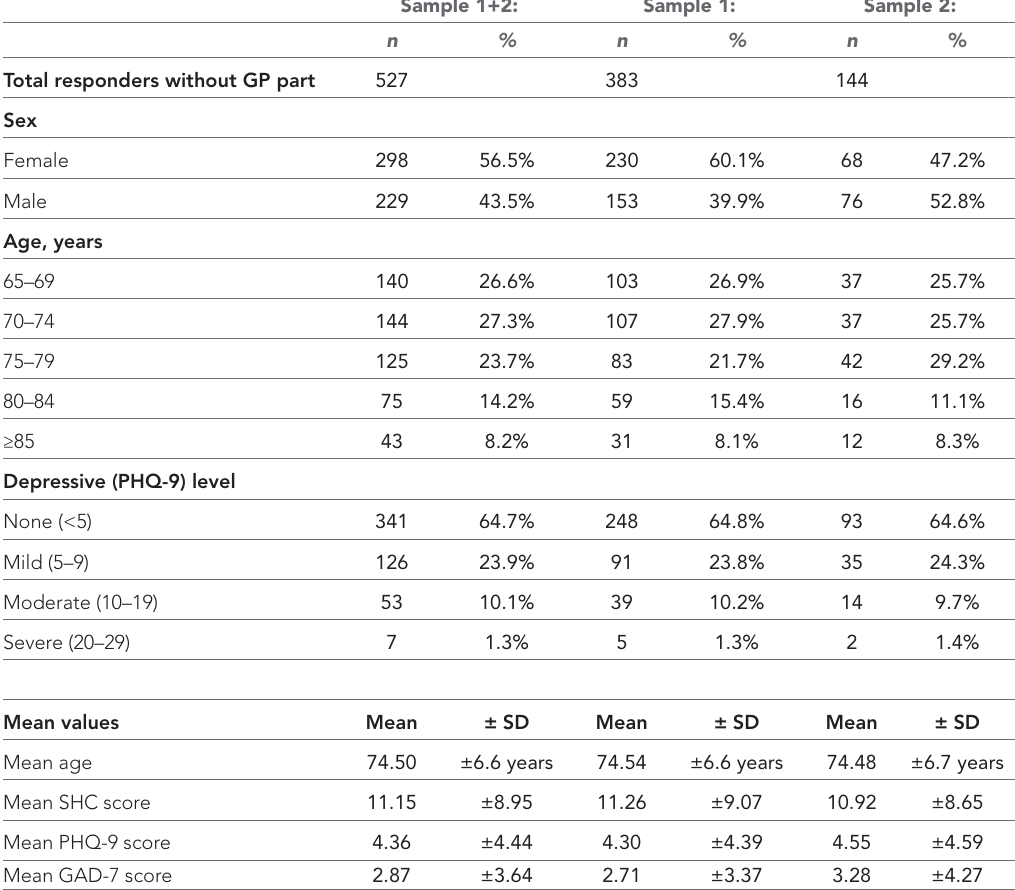
Table 2 Sample variation between the two different recruitment